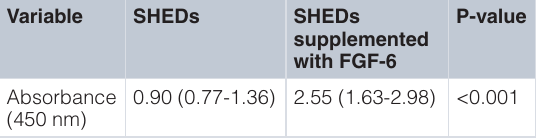
Table 1. Cell proliferation assay for both studied groups. Data presented as median